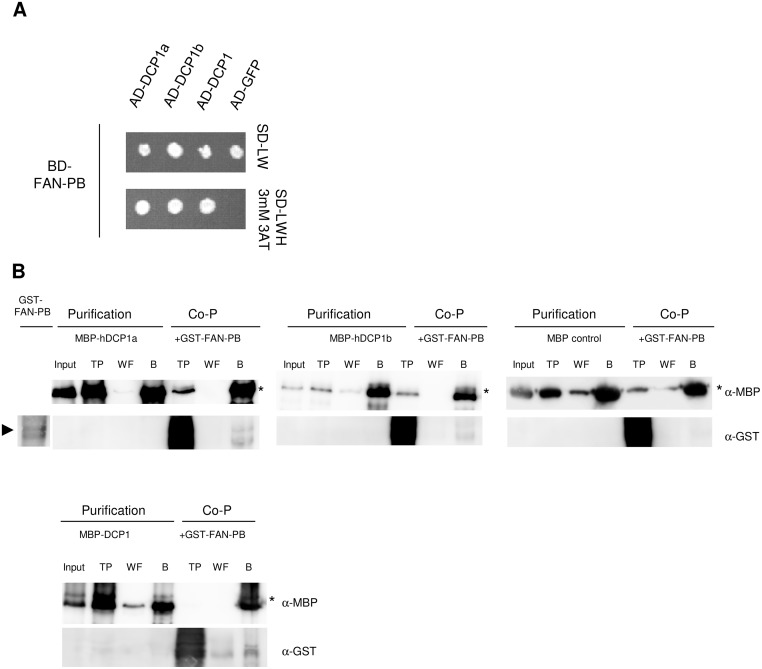
Inter- and intraspecific interactions between FAN-PB and DCP1 homologs.(A) Yeast two-hybrid interactions. Top part: double transformed yeast cells on selective dropout medium lacking leucine (-L) and tryptophan (-W). Bottom part: interactions between the FAN-PB N-terminally fused to the GAL4 Binding Domain (BD), the human DCP1 isoforms (DCP1a and b) and the Arabidopsis DCP1, N-terminally fused to the GAL4 Activation Domain (AD) on selective dropout medium lacking leucine (-L), tryptophan (-W), and histidine (-H), supplemented with 3 mM 3-Aminotrizole (3AT). GFP N-terminal fused to the GAL4-AD has been included as negative control. (B) Coprecipitations of bacterially expressed proteins. GST-FAN-PB (arrowhead, ~70 kDa) coprecipitated with MBP-DCP1a (~90 kDa), MBP-DCP1b (~92 kDa) and MBP-DCP1 from Arabidopsis, but not with MBP (~42 kDa) as negative control. Throughputs (TP), last wash fractions (WF), and resin bound fractions (B) are visualized by α-MBP (upper row) and α-GST antibody staining (lower row). Samples detected on different blots are separated by lines.